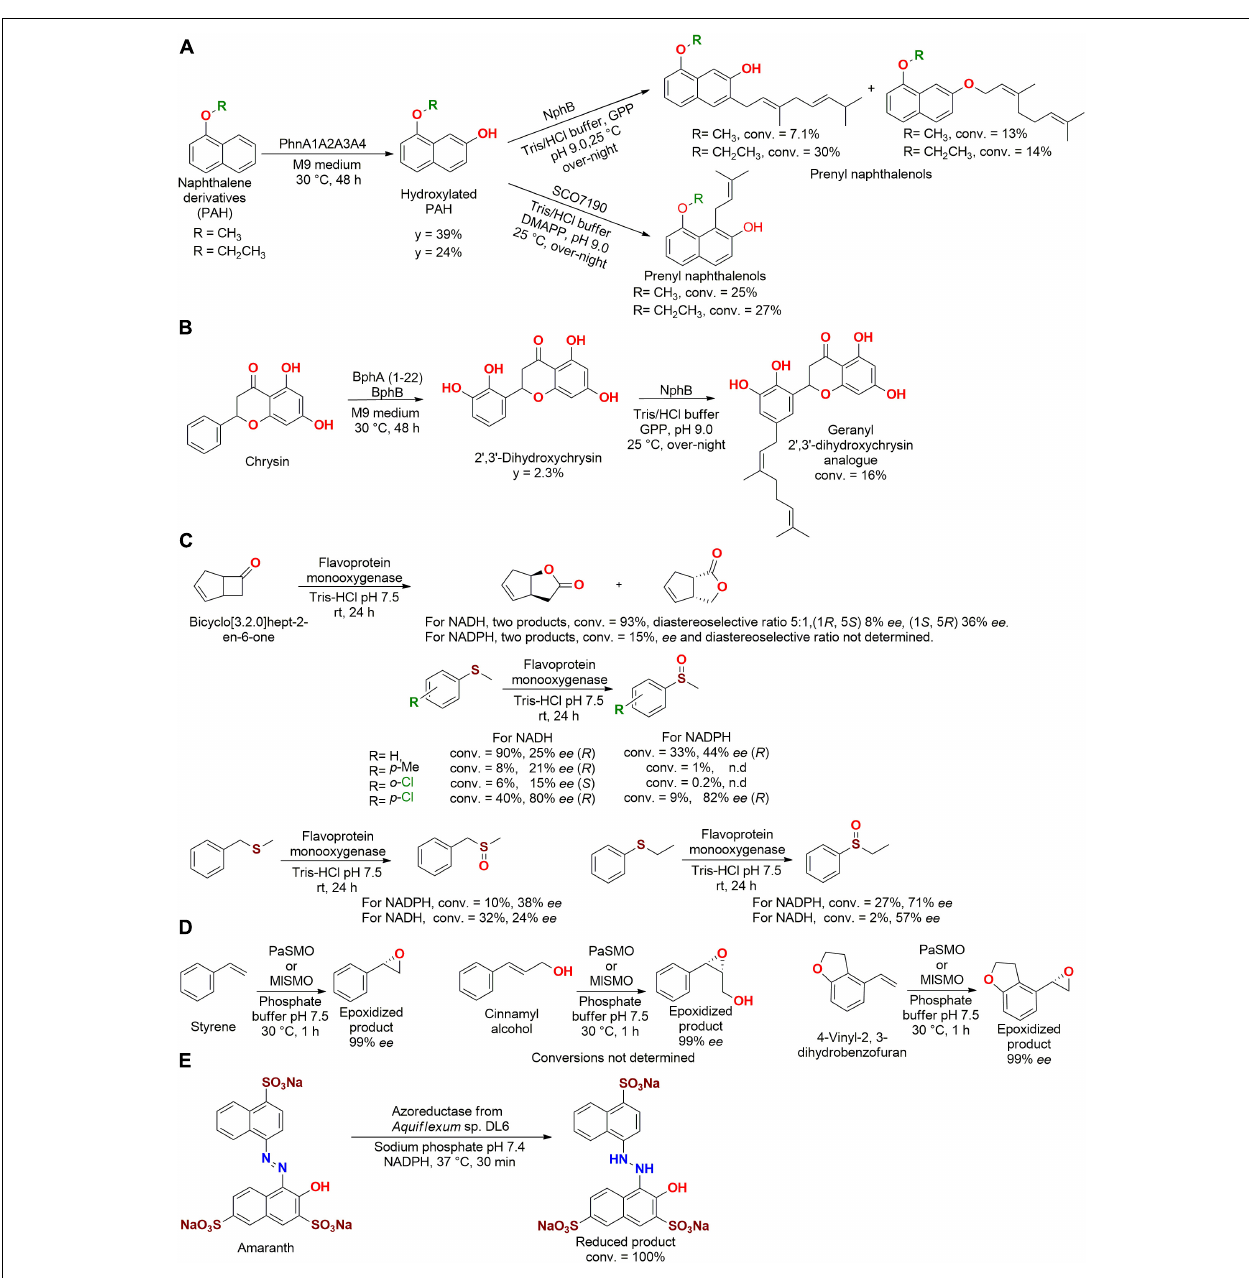
FIGURE 10 | Biotransformation of (A) naphthalene derivatives and (B) Chrysin by dioxygenase and prenyltransferase enzymes (Shindo et al., 2011). (C) Baeyer–Villiger oxidation and thioester oxidation by a flavoprotein monooxygenase (Jensen et al., 2012). (D) Epoxidation of styrene derivatives by two monooxygenases isolated from the genome of P. agarilytica NO2 and Marinobacterium litorale DSM 23545 (Pu et al., 2018). (E) Decolorization of Amaranth by an azoreductase enzyme from Aquiflexum sp. DL6 (Misal et al.,